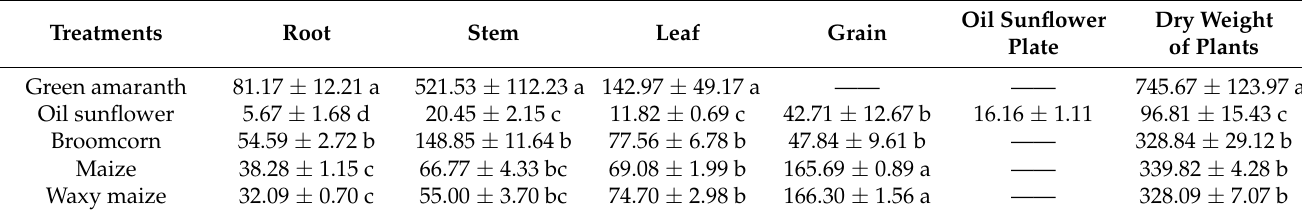
Table 1. The biomass of each part of different plants (g · pot − 1 ).